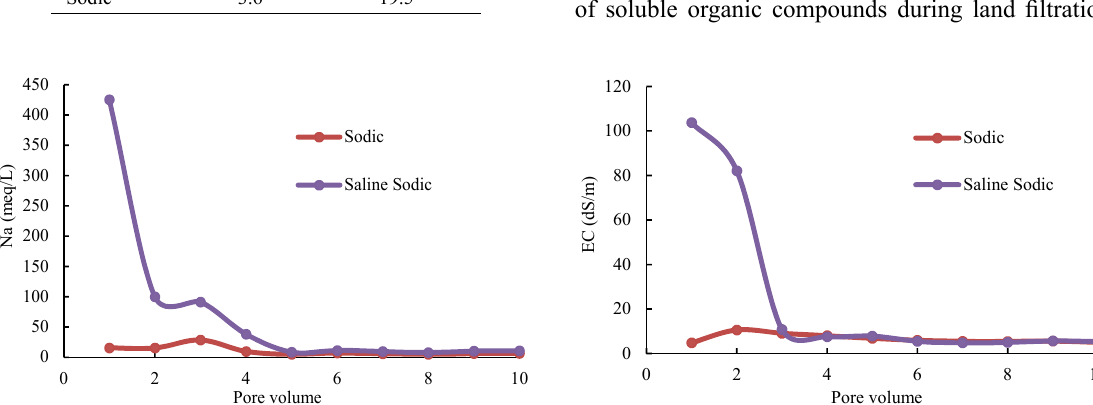
Fig.1: Changes of electrical conductivity and sodium in soil column leachate over leaching experiment at two saline-sodic and sodic soil